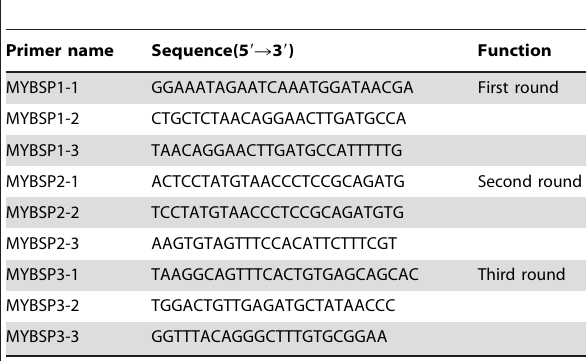
Table 3. Primers used to isolated the LcMYB1 promotor